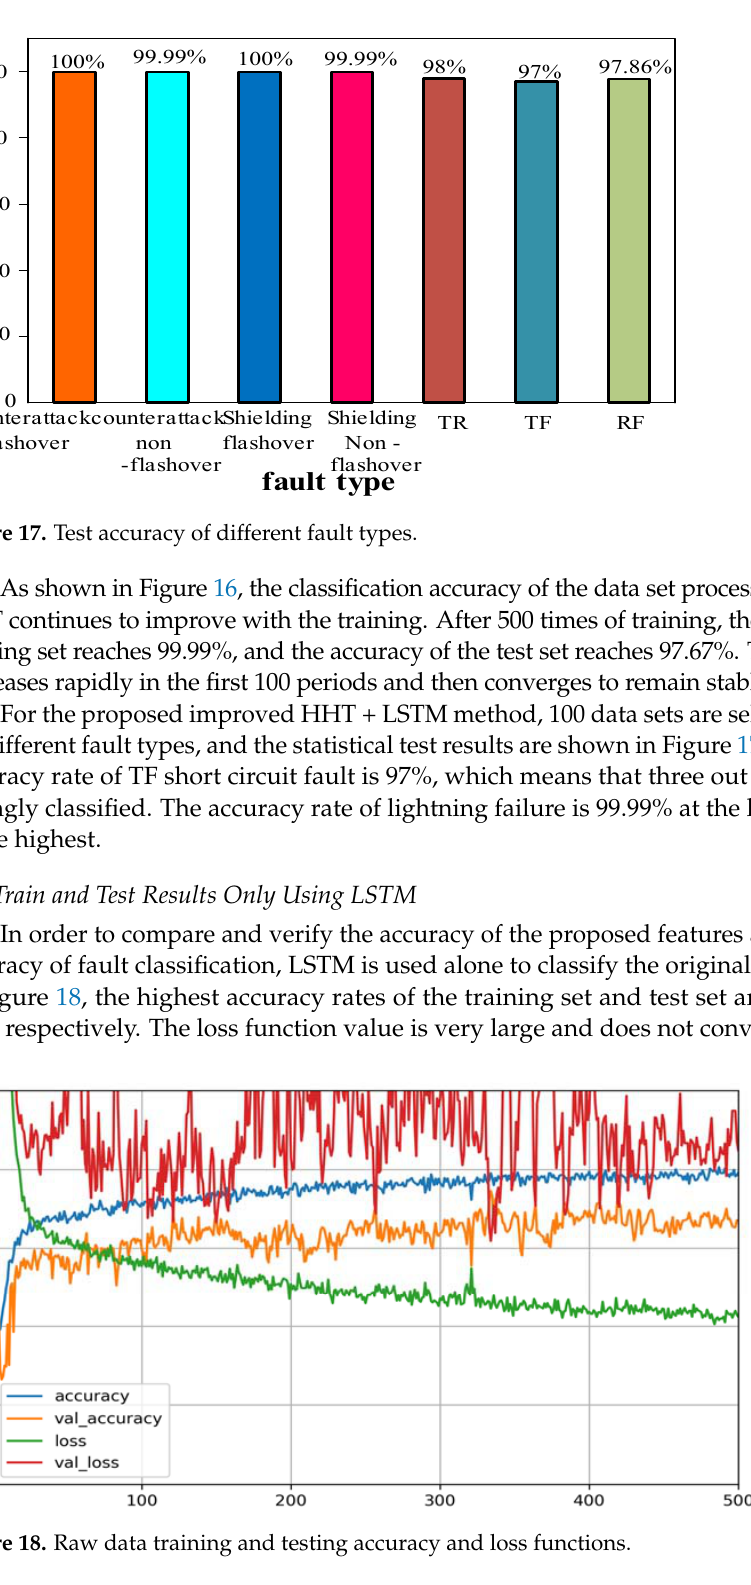
Figure 16. Accuracy and loss function after improved HHT post ‐ processing training and testing.